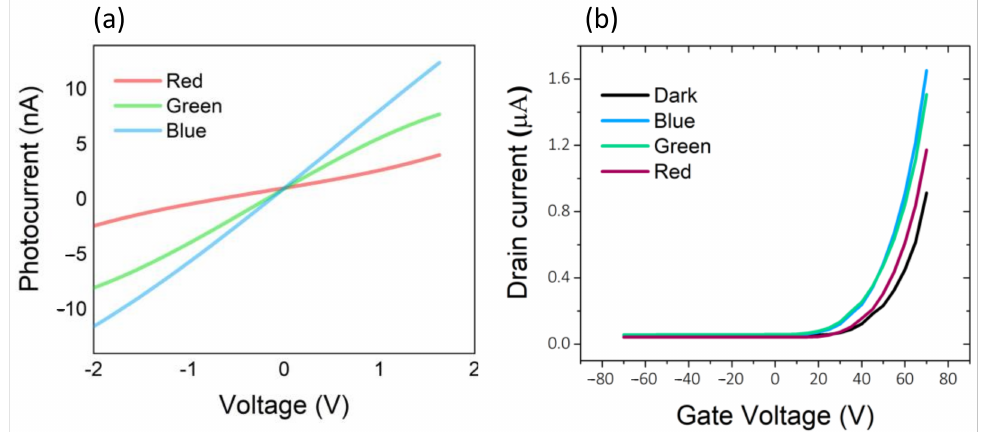
Figure 3. ( a ) Photocurrent of the device under light irradiation. ( b ) The transfer curves in light irradiations.